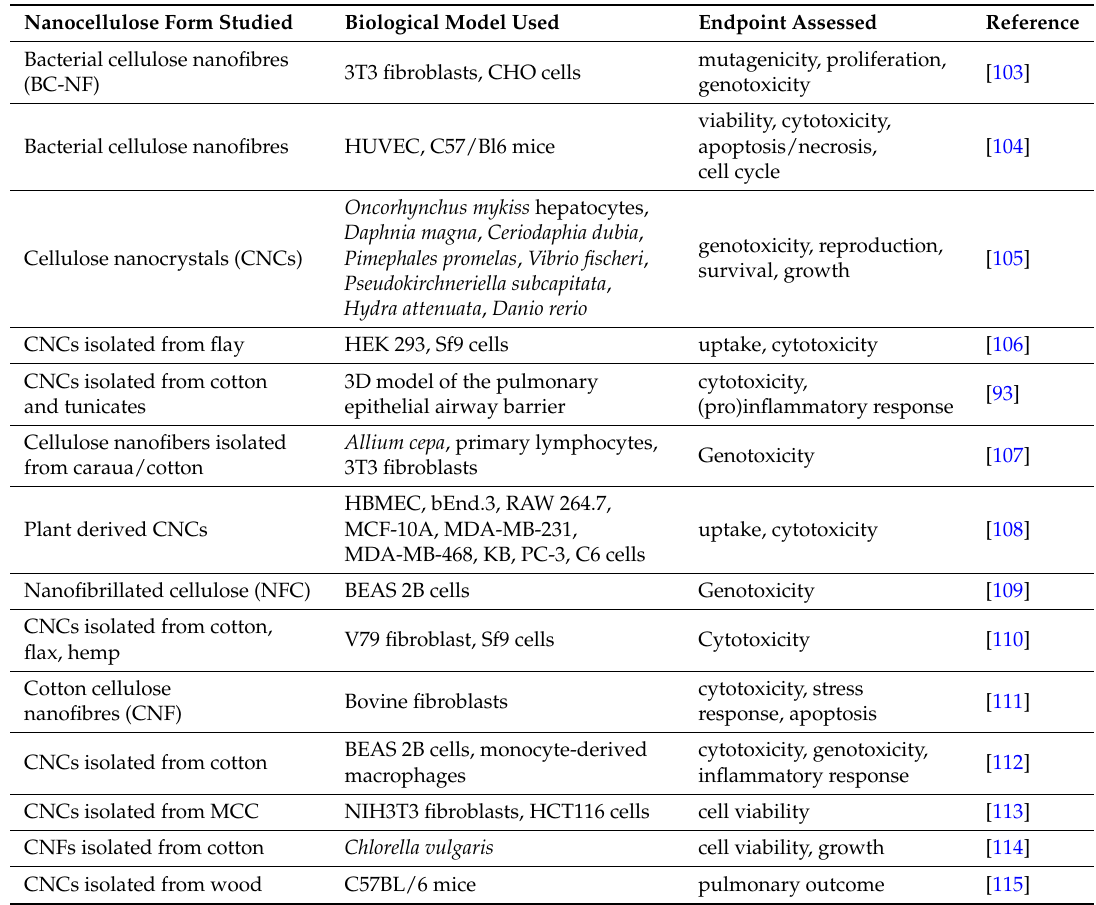
Table 2. An overview over the published studies focussing on the hazard assessment of nanocellulose. Details regarding the specific form of nanocellulose used, the biological system employed and the specific biochemical endpoint analysed are